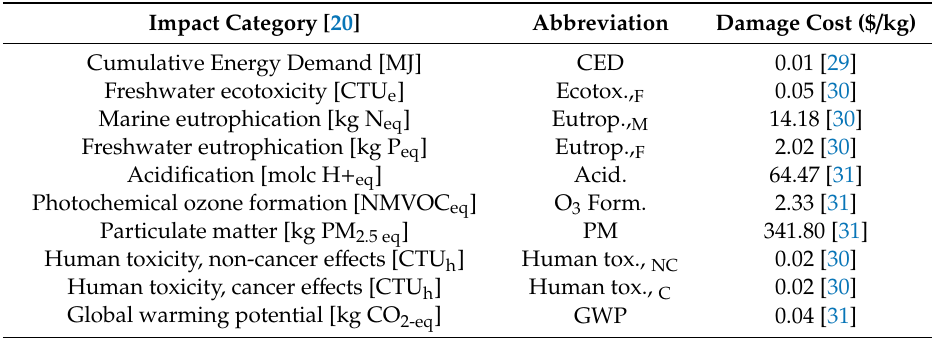
Table 1. Damage cost of di ff erent impact